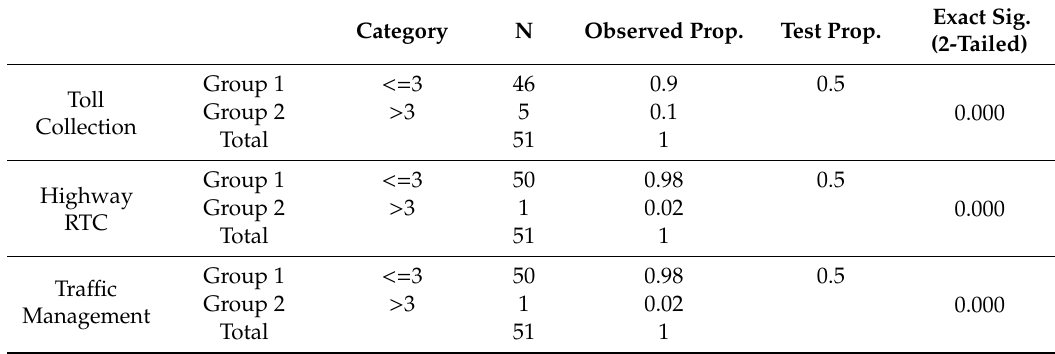
Table 6. Binomial test (Statistics) for IOT.